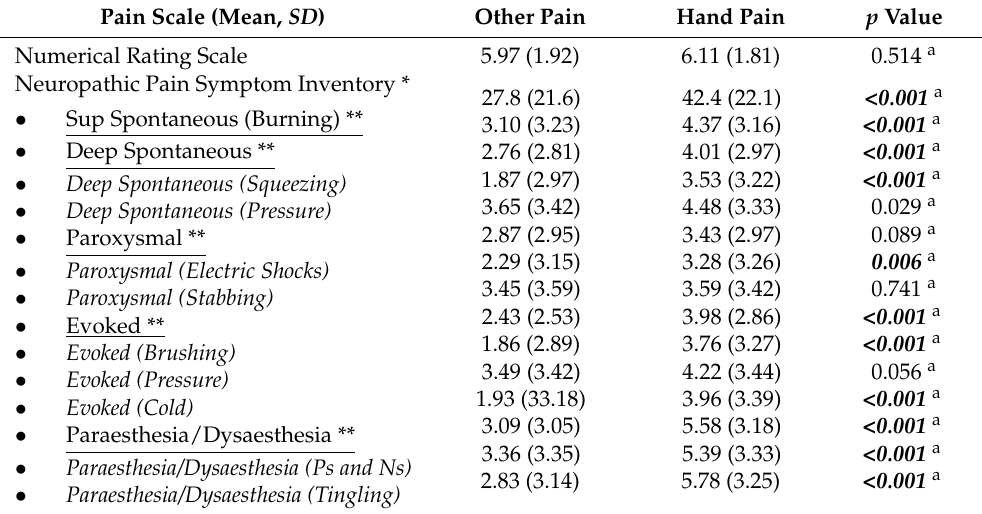
Table 3. Comparison of pain measures and symptoms by region of pain (excluding or including hand pain). Pain Scale (Mean, SD